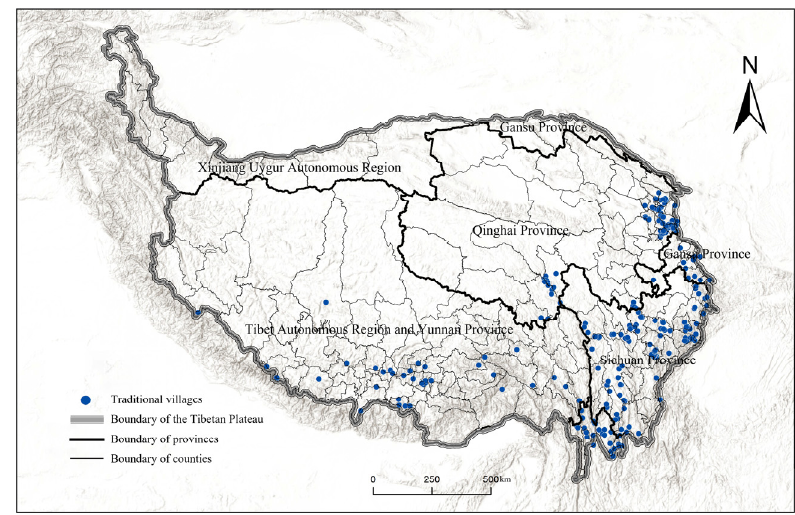
Figure 3. Distribution of traditional villages on the Tibetan Plateau.